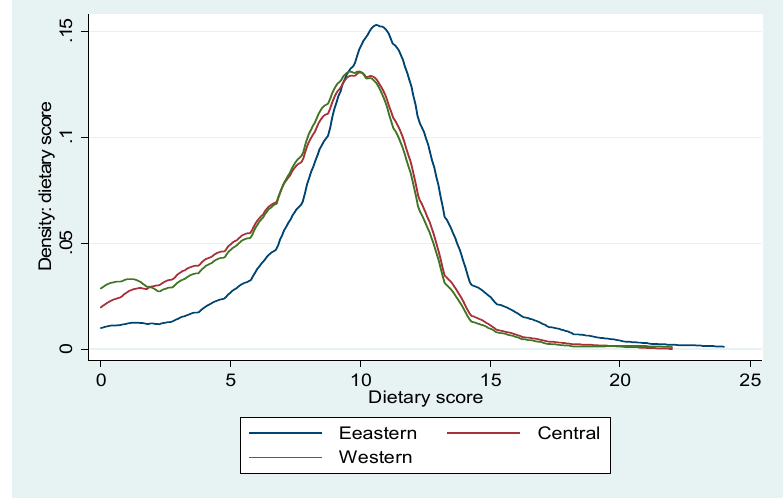
Figure 1. Distribution of dietary scores by geographic region.